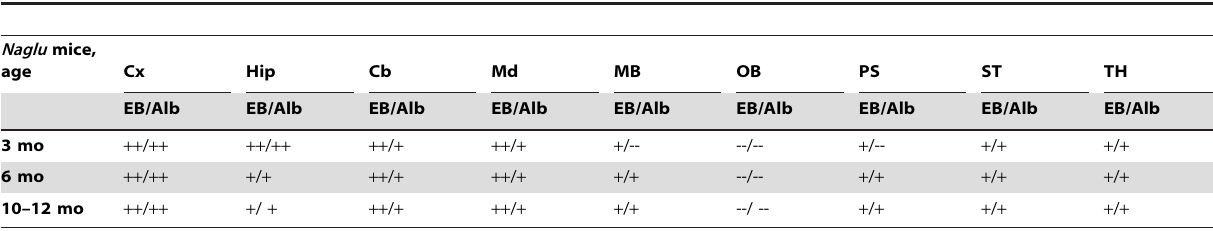
Table 1. Pattern of vascular leakage in the brains of Naglu mice at different stages of disease.